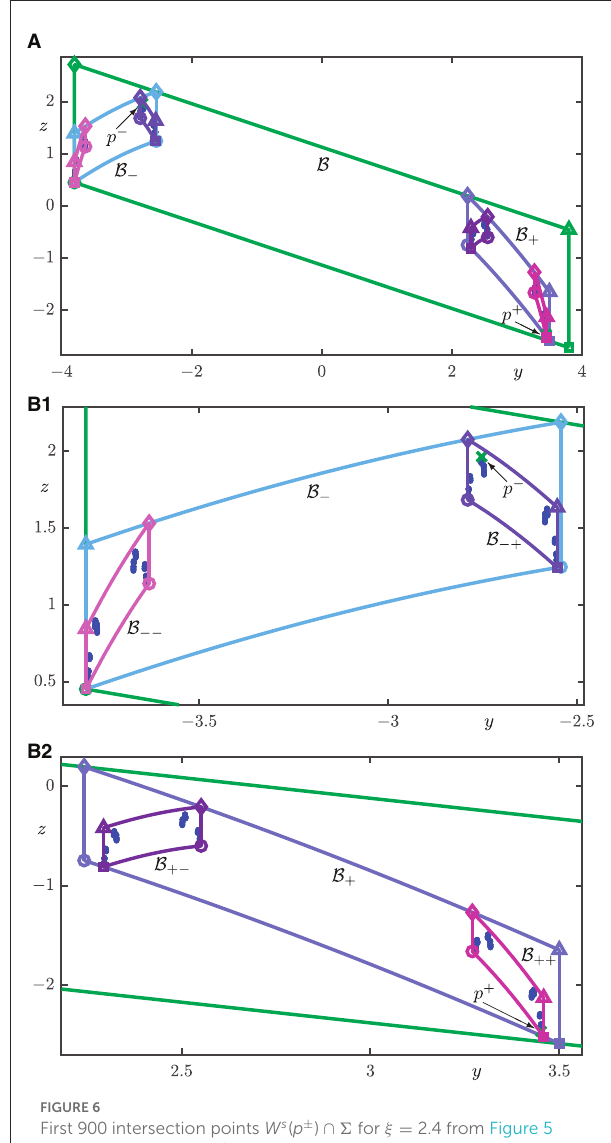
FIGURE6 First 900 intersection points W s ( p ± ) ∩ 6 for ξ = 2.4 from Figure 5 shown together with p ± and the intersection sets of B (green), B − (light blue), B + (dark blue), B −− (light magenta), B −+ (light purple), B +− (purple), and B ++ (magenta). (A) shows all of 6 ∩ B , and (B1, B2) are enlargements of B − and B + , respectively.